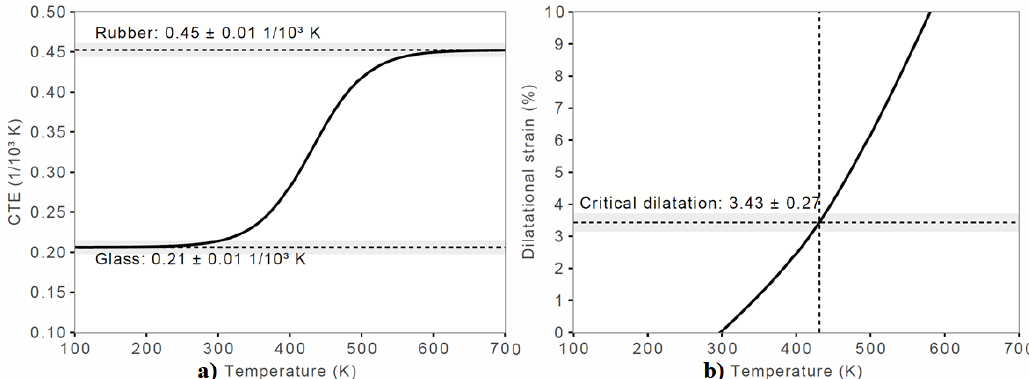
Figure 3. Dilatometric analysis: ( a ) CTE vs Temperature; and ( b ) Dilatational strain vs Temperature. The unit-cell geometry of o-PEEK was used for MD simulation, with the starting and ending temperatures for equilibration being 700 and 100 K, respectively, with the step size of 30 between them.